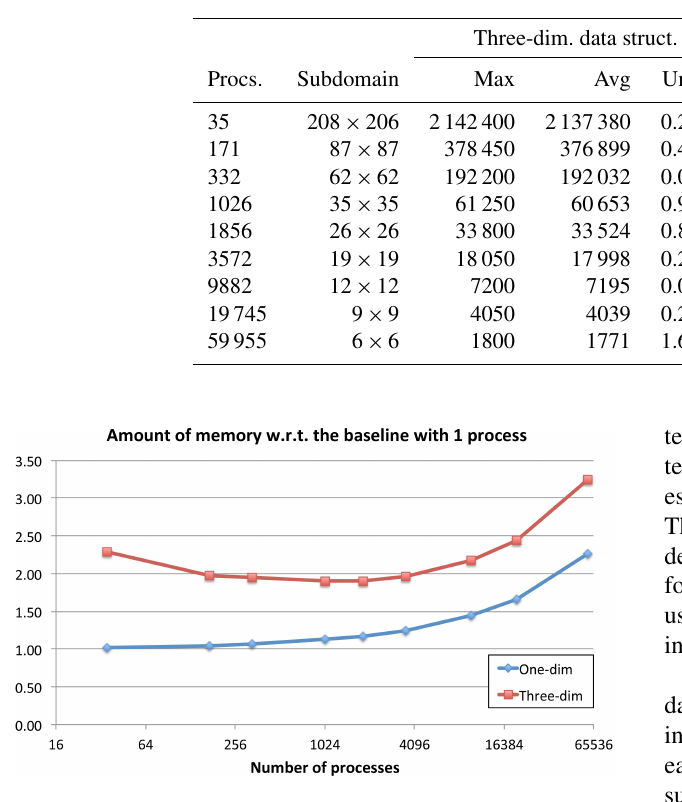
Figure 12. Amount of memory allocated using three- and one- dimensional data structures. The values refer to the minimum amount of memory allocated in a sequential